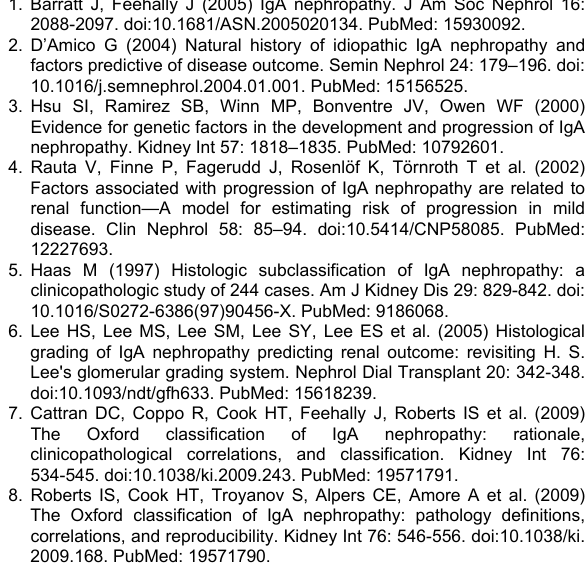
Table S3. The significant cellular components with related proteins and p-values for under-represented markers.